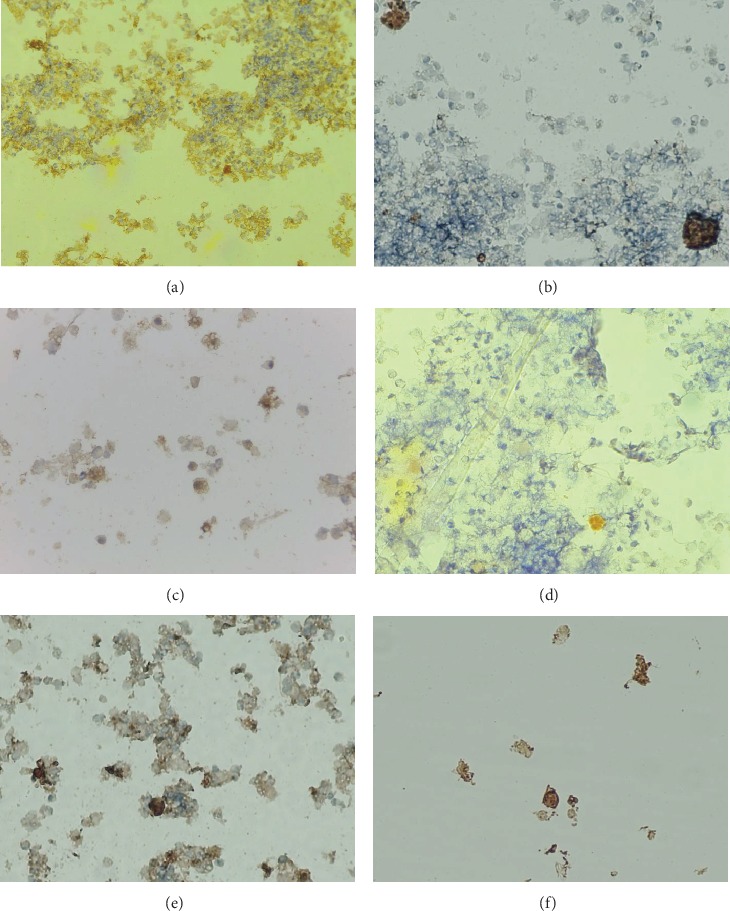
Expression of cytokines in milk by biotin-streptavidin immunocytochemistry method: (a) TNF-α, 100x; (b) TNF-α, 400x; (c) IL-1, 400x; (d) IL-10, 400x; (e) BD-2, 400x; (f) caspase-6, 400x. The brown colour in the cytoplasm and cell nuclei indicates a positive presence of cytokines.